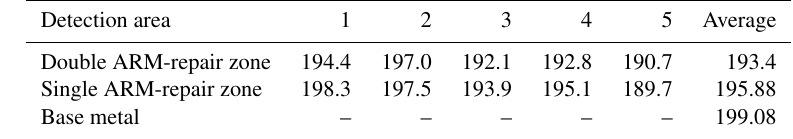
Table 4. Comparison of the Vickers hardness test results (HV0.1).